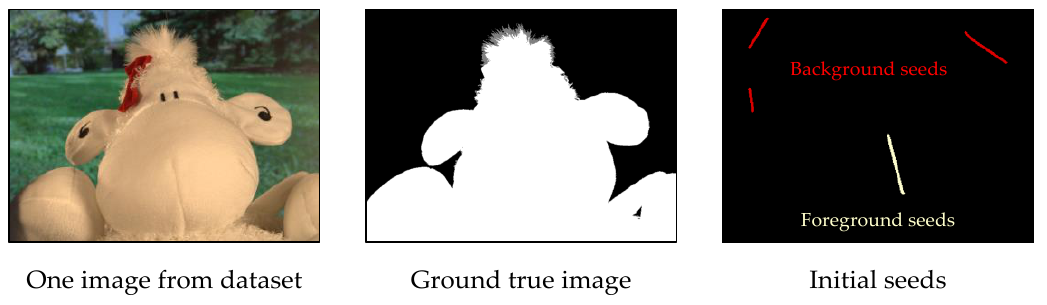
Figure 8. The evaluation samples from dataset.